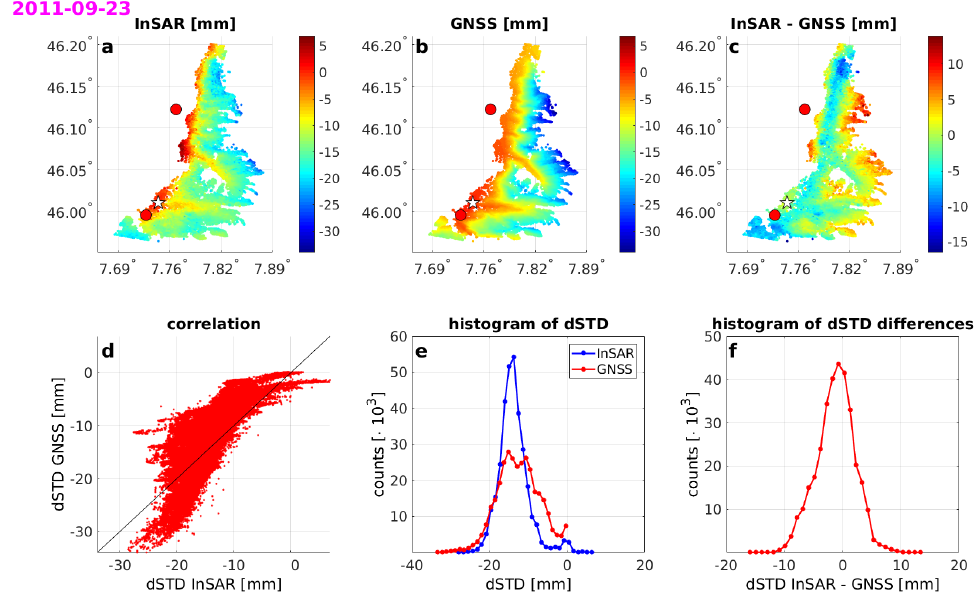
Figure 7. Comparison between InSAR and GNSS estimates for a day with a good agreement (23 September 2011). The plots show ( a ) InSAR-based dSTD s for all PS points; ( b ) GNSS-based dSTD s for all PS points; ( c ) the differences between ( a , b ); ( d ) the correlation between techniques; ( e ) the histograms of dSTD values for both techniques and ( f ) the histogram of differences dSTD InSAR − dSTD GNSS . The white star indicates the reference point and red dots the GNSS stations within the research